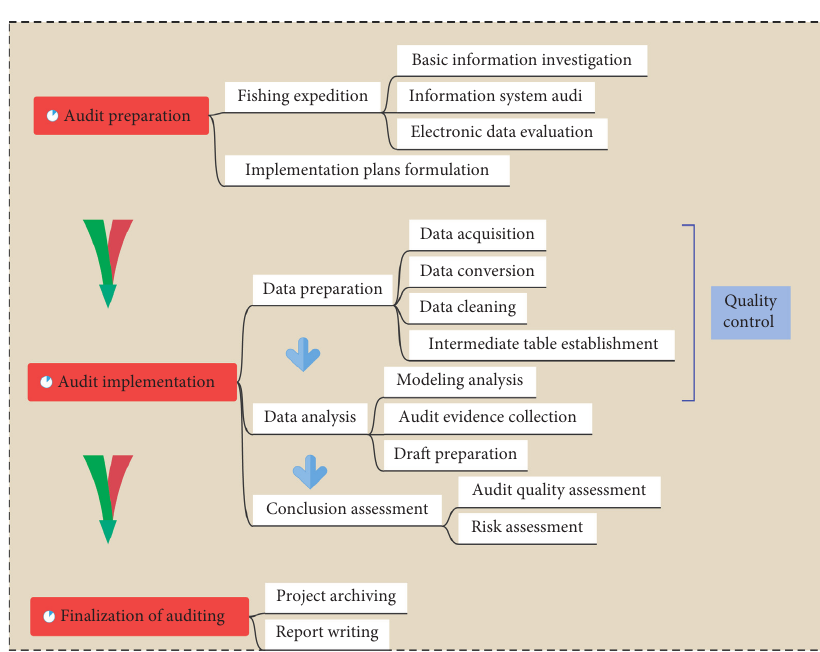
Figure 3: Flowchart of online audit.